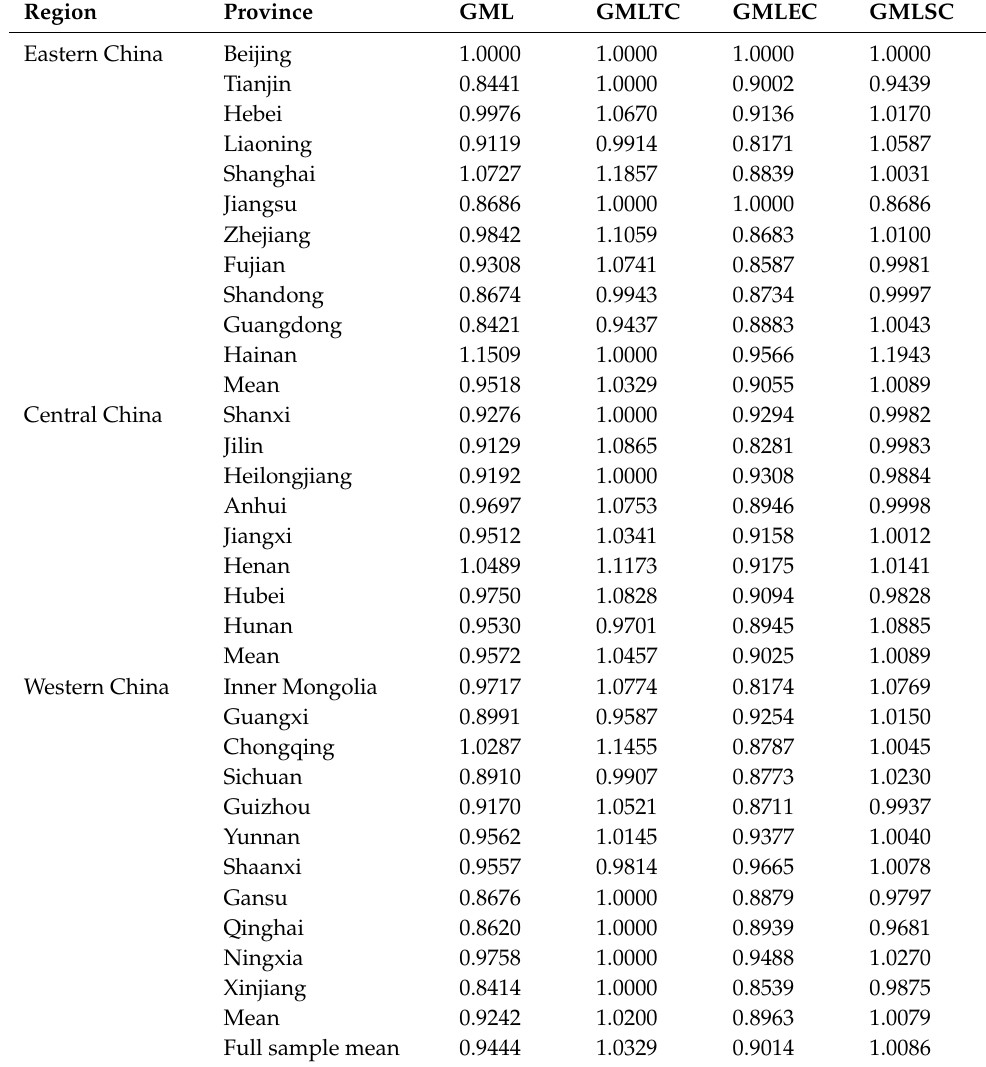
Table 6. Average values of GML and its decomposition